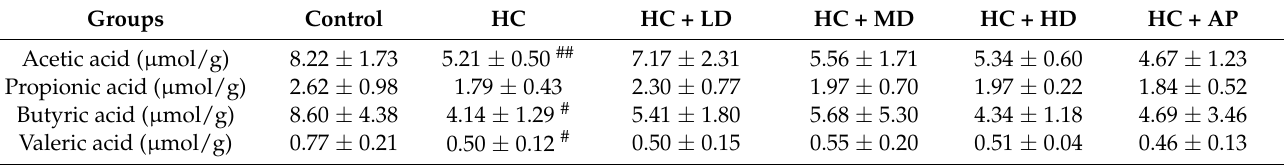
Table 5. Effects of TCI227 on fecal short-chain fatty acids (SCFAs) in PO-induced hyperuricemia SD rats.